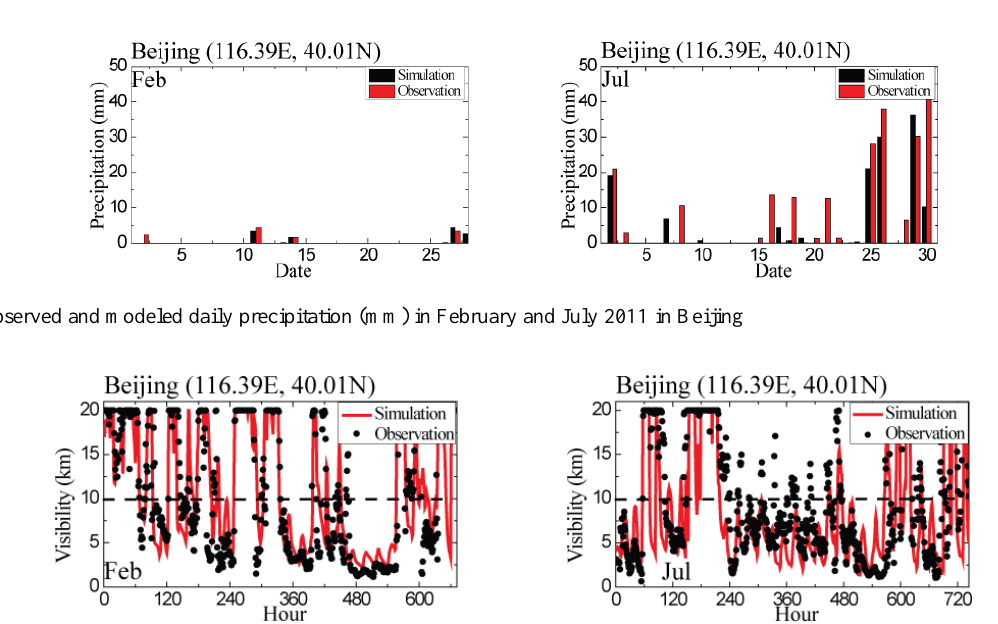
Figure 9. Observed (black circles) and modeled (solid red lines) hourly visibility (km) in February and July 2011 in Beijing.